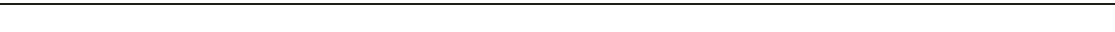
Fig 5 Hh-activated CAFs form a reversible, chemo-resistant CSC niche via FGF pathway activity. a RT-qPCR analysis of Fgf5 expression in M6 whole tumors. n = 3 biological replicates per treatment group with three technical replicates per assay. Statistical signi fi cance was determined using unpaired two-tailed Student ’ s t test with equal s.d. b Expression of Fgf5 at single-cell resolution in M6 tumor models. Freshly isolated M6-Ctrl (blue), M6-Hh (magenta), and M6-Hh tumors + SMOi (100 mg/kg/bid; violin dots) were captured using 10x Chromium technology. t -SNE plot represents the subcellular clusters present in the breast TME of M6 tumors. A sole subset of Hh-activated CAFs exhibits robust expression of Fgf5 in M6-Hh tumors. c Representative immunohistochemistry staining for phospho-FGFR on M6 tumors. Scale bars: 100 μ m. Quanti fi cation of phospho-FGFR-positive cancer cells at the tumor − stromal interface. n = 4 biological replicates per treatment group; statistical signi fi cance was determined using unpaired two-tailed Student ’ s t test with equal s.d. d Relative mRNA expression of CSC markers Id3 and Sox10 in M6-Ctrl cells treated with DMSO (vehicle; blue) or recombinant FGF5 (red) in vitro . n = 3 biological replicates with three technical replicates per experiment; statistical signi fi cance was determined using unpaired two-tailed Student ’ s t test. e Primary and secondary tumorsphere formation of M6-Ctrl cells treated with DMSO (vehicle; blue) or recombinant FGF5 (red). Sphere Formation Ef fi ciency (SFE) values in % are mean ± s.e.m.; n = 3 biological replicates with three technical replicates per tumorsphere assay. Representative phase contrast micrographs of M6-Ctrl spheres upon recombinant FGF5 stimulation. Scale bars: 100 μ m. f Cell viability of M6-Ctrl and M6-Hh cells treated with indicated agents ( n = 5 biological replicates with six technical replicates each). Statistical signi fi cance was determined using unpaired two-tailed Student ’ s t test with equal s.d.; * P < 0.05; ** P < 0.01; *** P < 0.001. Bars represent mean ±